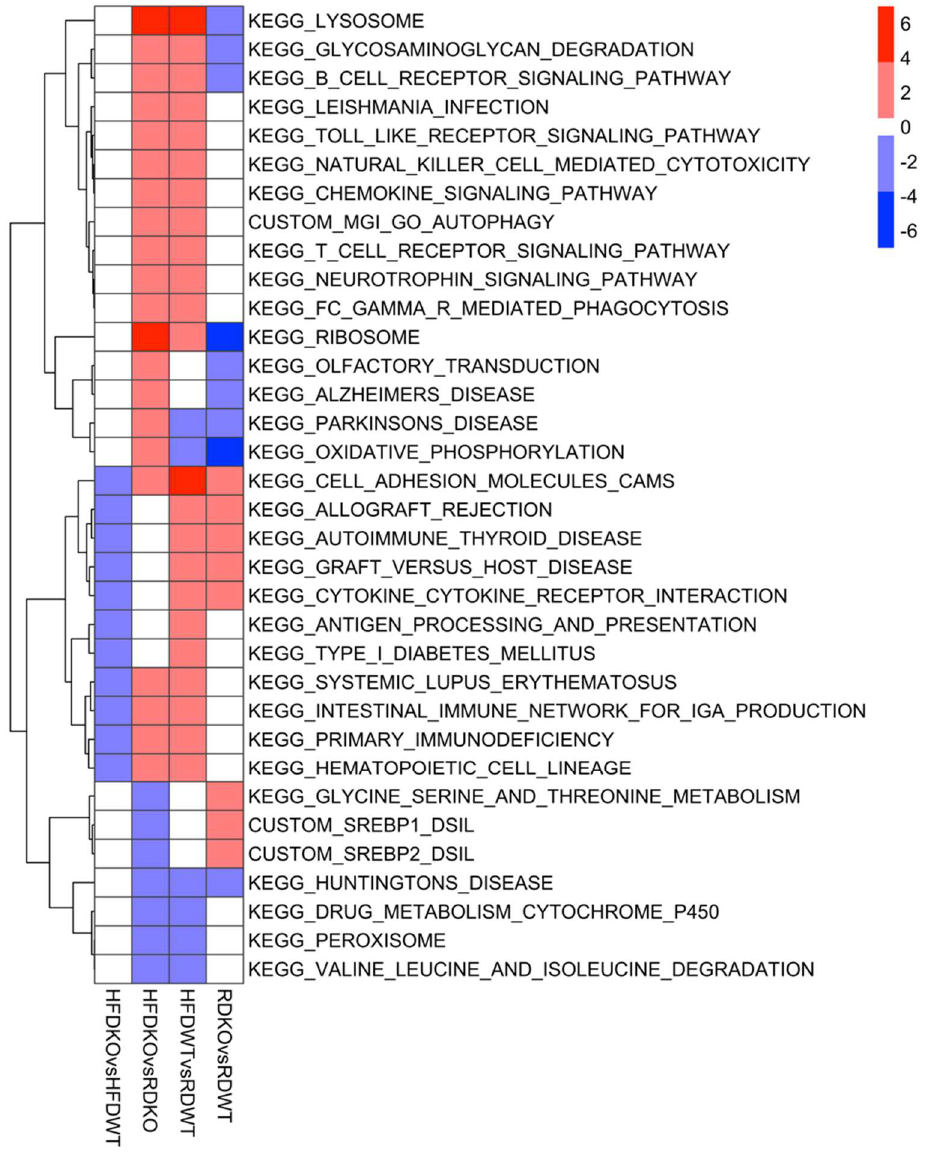
Figure 10. Heatmap summarizing significantly up—(red) or down—(blue) regulated as determined by GSEA (FDR ≤ 0.05). Pathways showing significant regulation (FDR ≤ 0.05) in two or more diet or genotype comparisons are shown. RD = chow diet, HFD = high-fat diet, WT = Lama4 fl/fl (control) mice, KO = Lama4 AKO mice. For the HFDKO vs. HFDWT column, pathway directionality reported is for the HFDWT group (i.e., red = upregulated in HFDWT vs. HFDKO). For the HFDKO vs. RDKO column, directionality is reported for the RDKO group. For the HFDWT vs. RDWT and RDKO vs. RDWT columns, directionality is reported for the RDWT group.